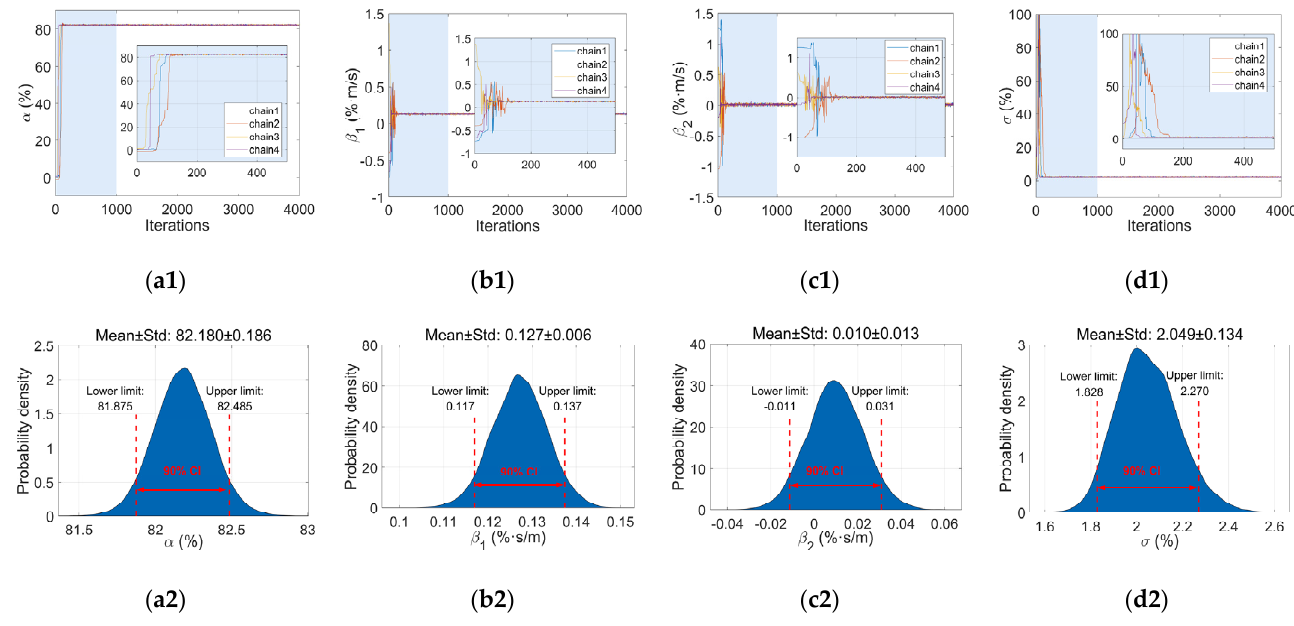
Figure 4. (Color Online) Traditional Bayesian estimation results of parameters with data from the first week only. ( a1 – d1 ) Markov chains of parameters α , β 1 , β 2 , and σ , and ( a2 – d2 ) posterior distribution of parameters α , β 1 , β 2 , and σ .